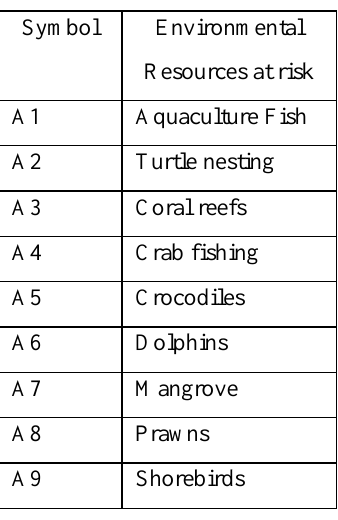
Table 1: Environmental resources at risk in the study area